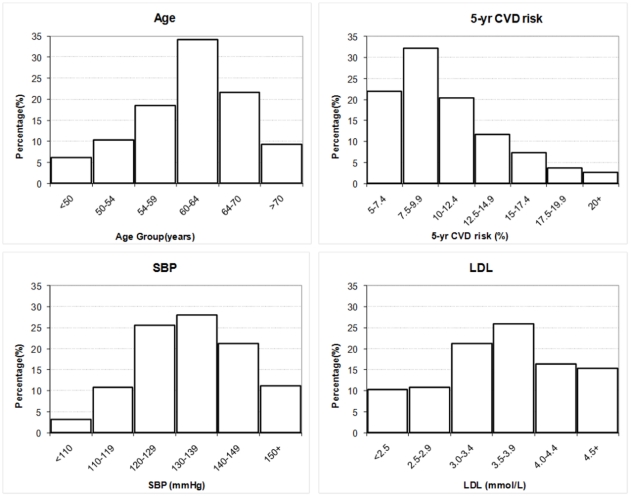
Baseline frequency distributions of age, LDL-cholesterol, SBP and 5-year
cardiovascular risk.This figure shows the frequency distribution of participants according to
their baseline levels of age, LDL-cholesterol, SBP and 5-year cardiovascular
risk.